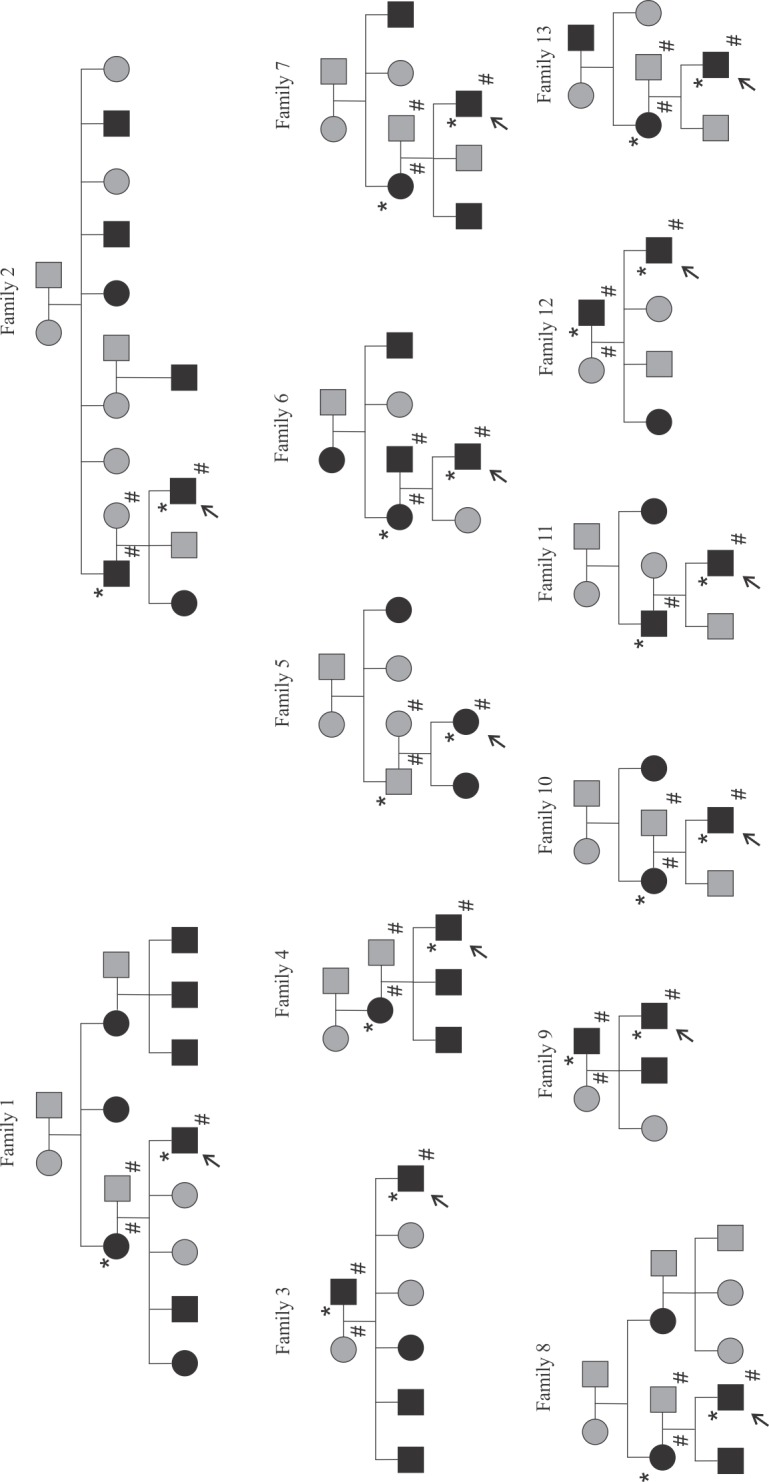
Pedigrees of the 13 families included in the study.Circles represent females and squares are males. Filled circles are classified as affected with CDGP, while shaded circles are unknown or do not fulfill the criteria for CDGP. The proband from each family is marked with an arrow. Individuals with an asterisk (*) have been sequenced at the pericentromere of chr 2. All probands and both of their parents were genotyped (denoted with the symbol #) except family 11, in which only the proband and affected parent were genotyped.